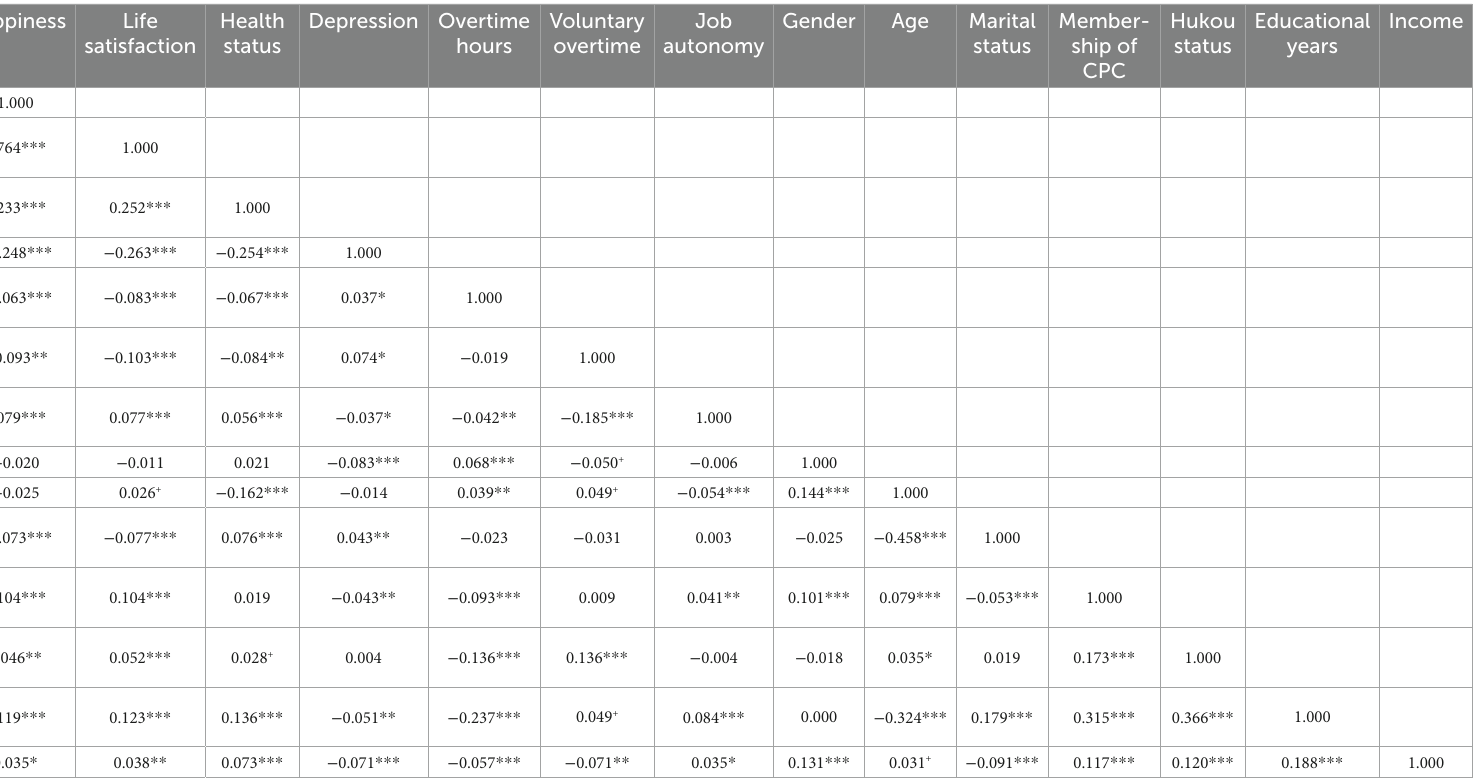
TABLE 2 General characteristics of variables and bivariate correlation ( N = 4,007). Mean S.D.